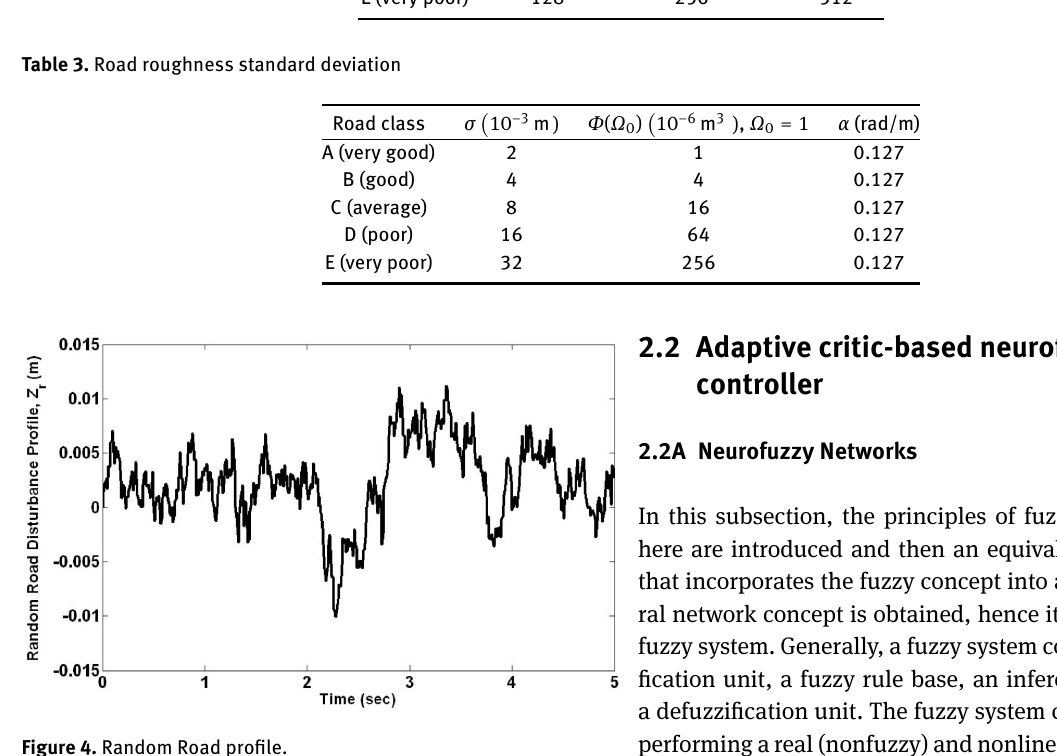
Figure 4. Random Road